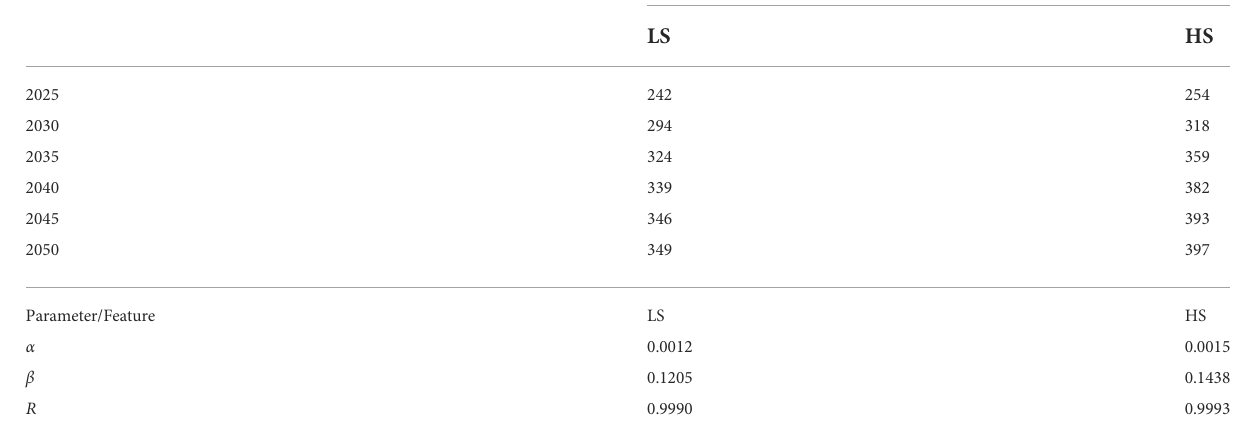
TABLE 4 Estimation of passenger vehicle ownership per thousand people in